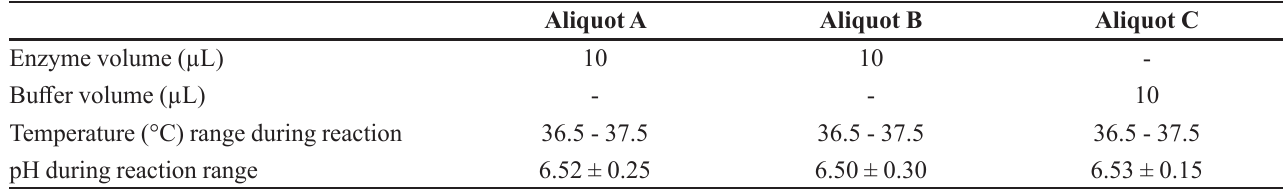
TABLE I - Experimental conditions for a three hour enzymatic assay for 5 mL urine